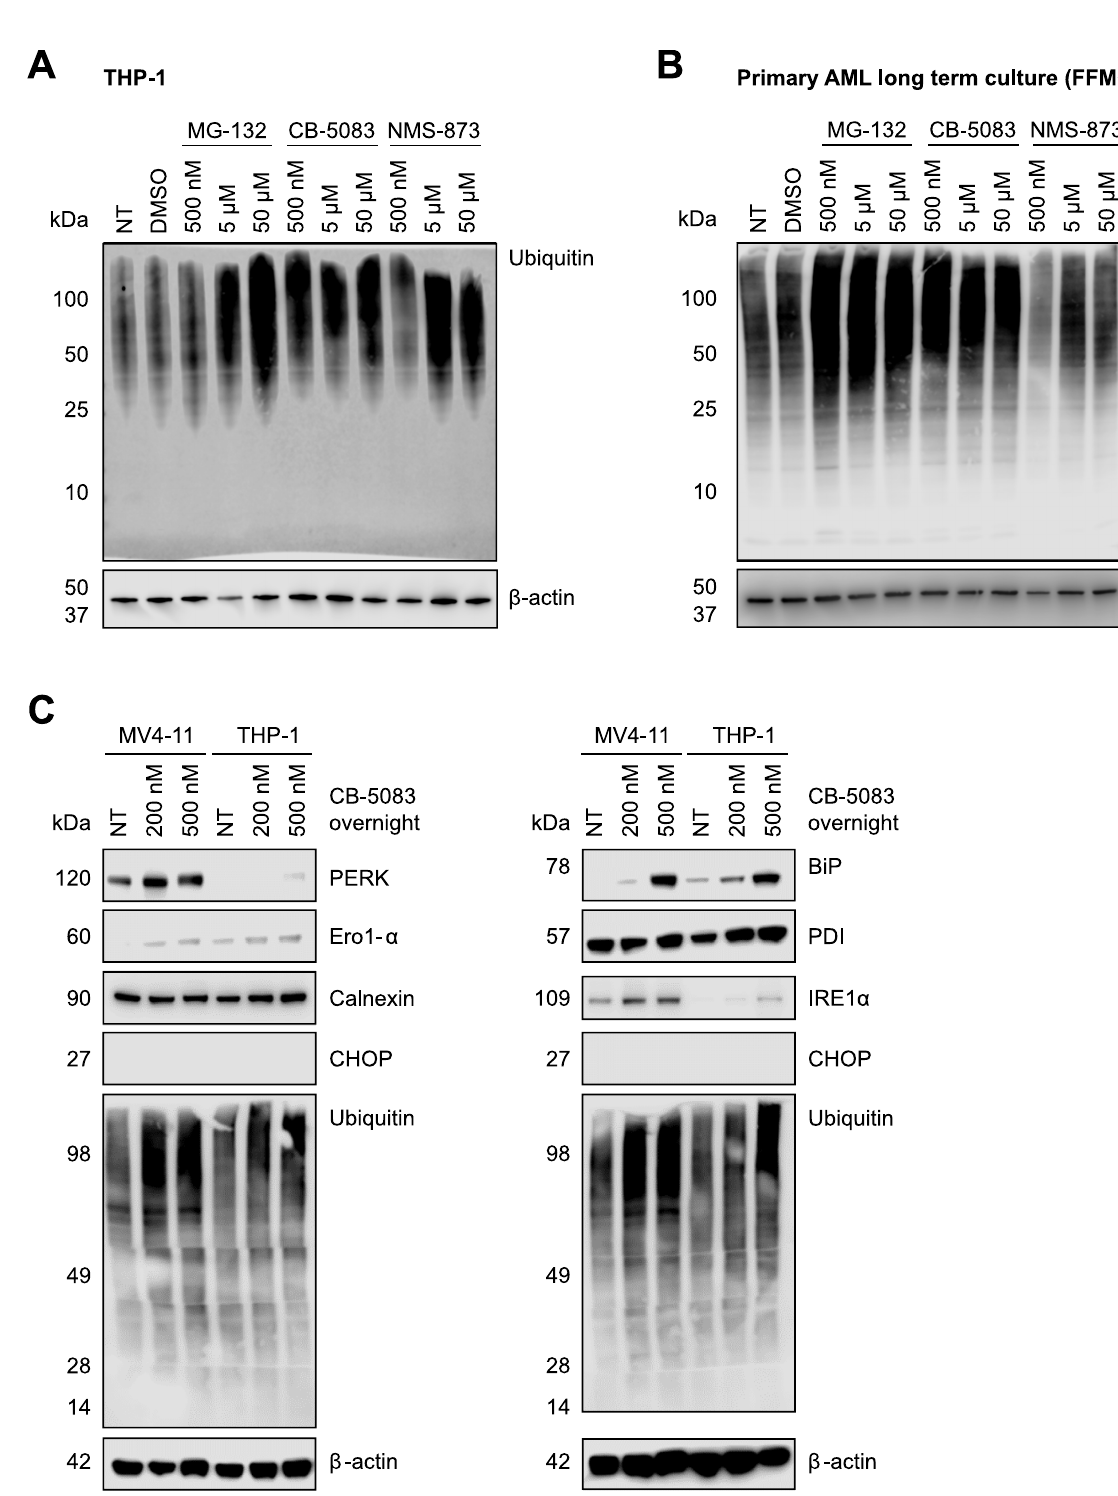
Fig 1. Inhibition of VCP leads to accumulation of ubiquitylated proteins and activates the unfolded protein response (UPR) in human acute myeloid leukemia (AML) cells. Immunoblot showing poly-ubiquitylated proteins in THP-1 cells (A) and in a primary human AML long-term culture (FFM05) (B) after treatment with the VCP inhibitors CB-5083 or NMS-873 or the proteasome inhibitor MG-132. (C) Immunoblot showing expression of UPR-associated proteins in THP-1 and MV4-11 cells after treatment with 200 or 500 nM CB-5083 overnight.